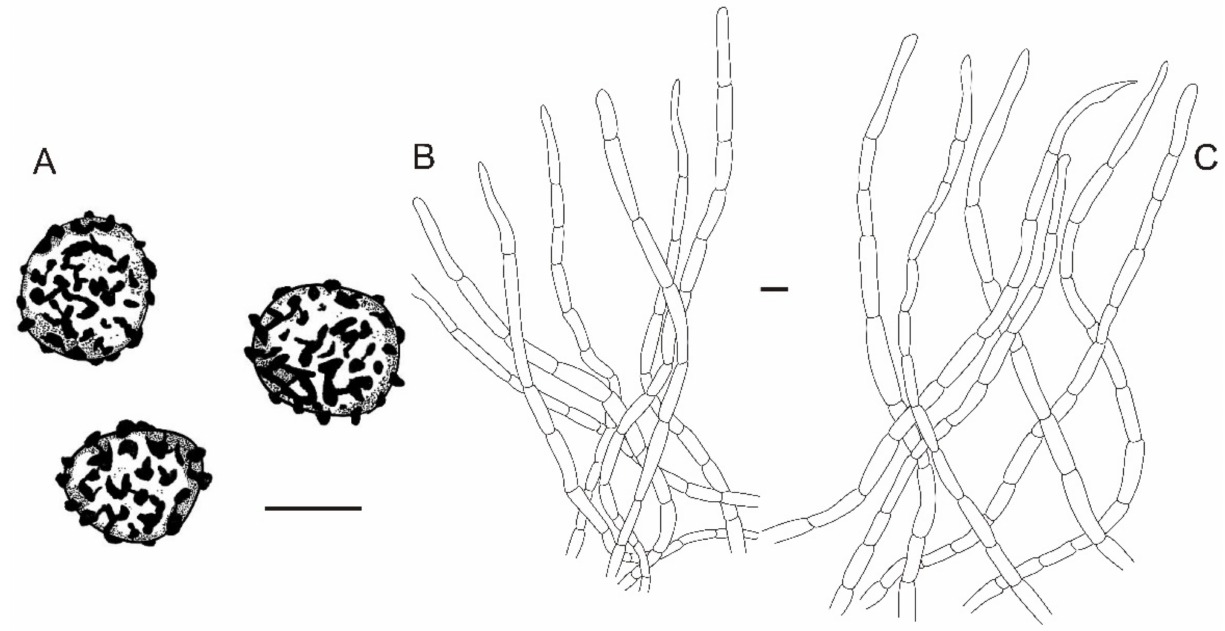
Figure 18. Microscopic features of Russula sinorobusta (BJTC Z052). ( A ) Basidiospores. ( B ) Hyphal terminations near the pileus margin. ( C ) Hyphal terminations near the pileus center. Scale bar: ( A ) = 5 µ m; ( B , C ) = 10 µ